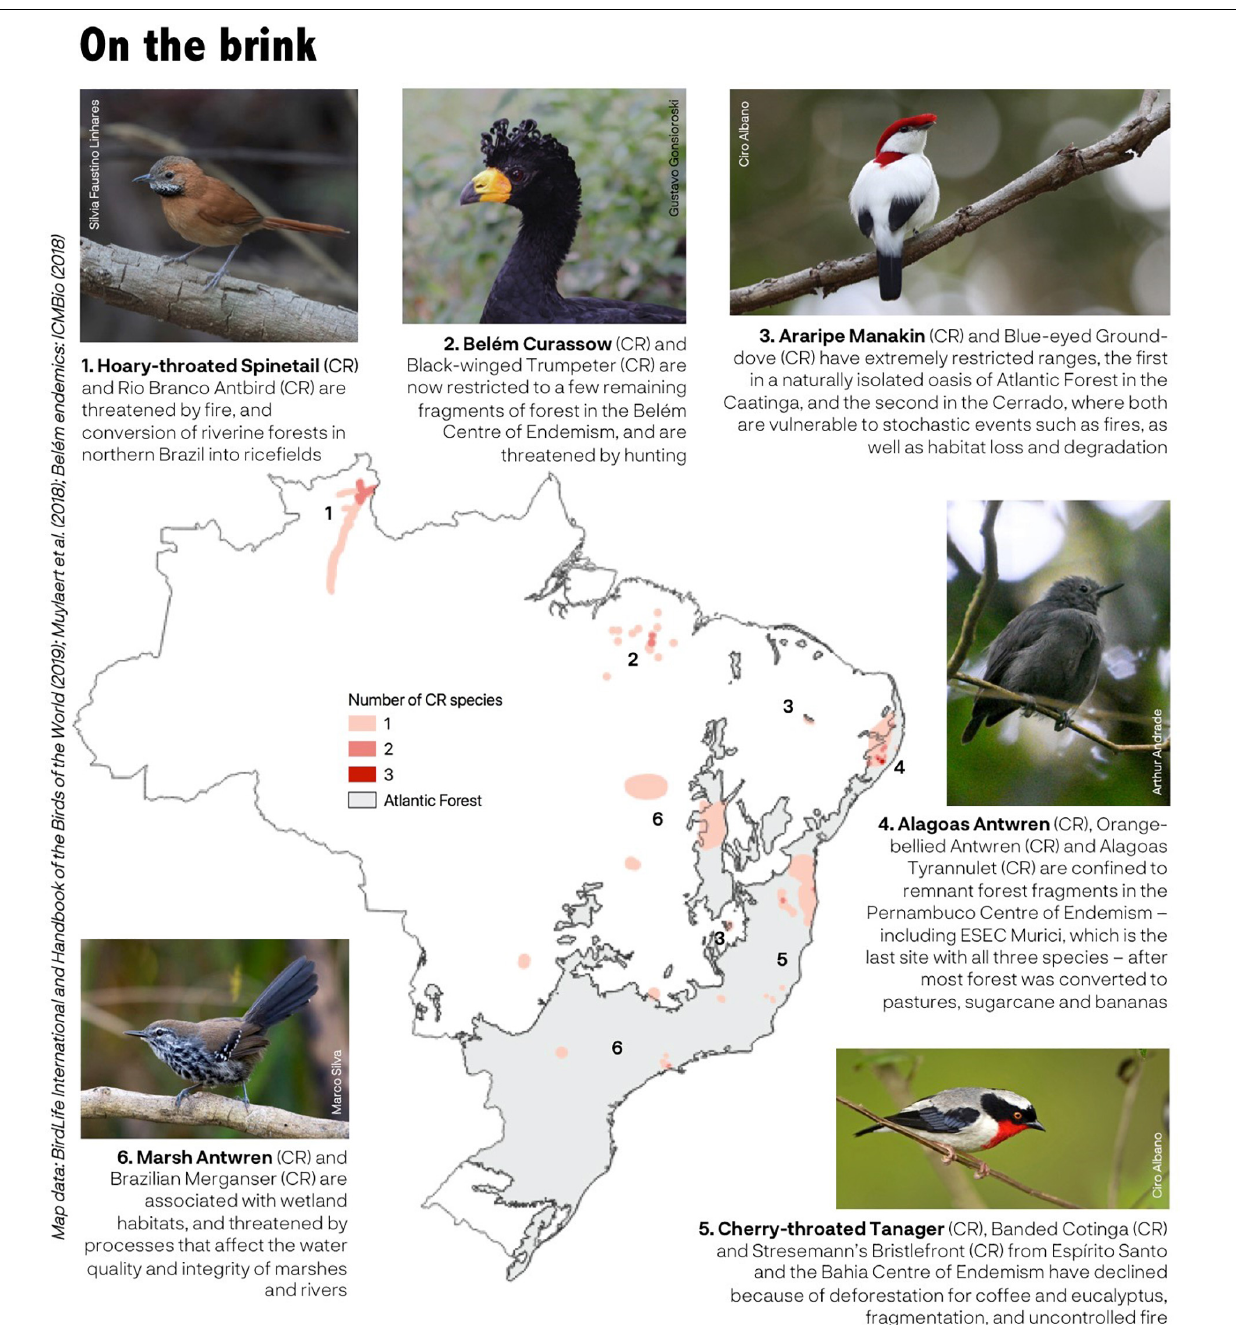
FIGURE 1 | Distributions of globally Critically Endangered bird species of Brazil, except for those already included as possibly extinct (see Table 1 ). Map data: Muylaert et al. (2018), BirdLife International, and Handbook of the Birds of the World (2019), Belém endemics: ICMBio (2018).